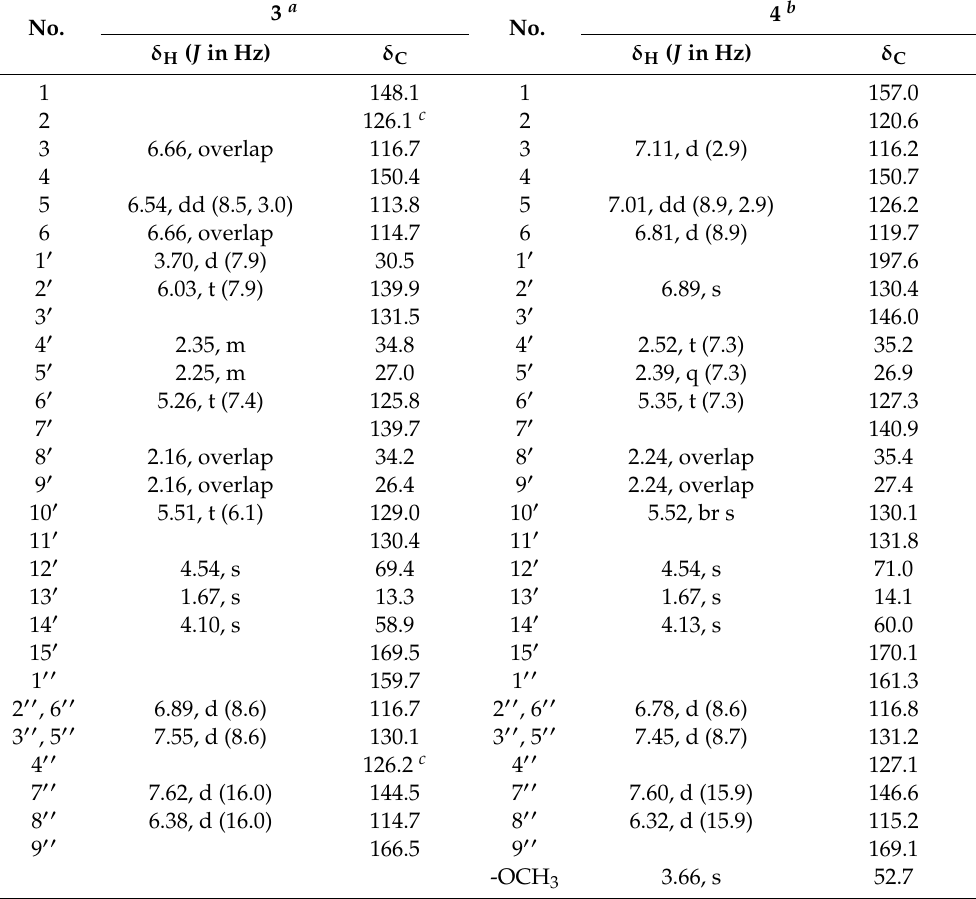
Figure 3. The calculated and experimental ECD spectra of 1 and 2 . Table 2. 1 H- and 13 C-NMR data of 3 and 4.